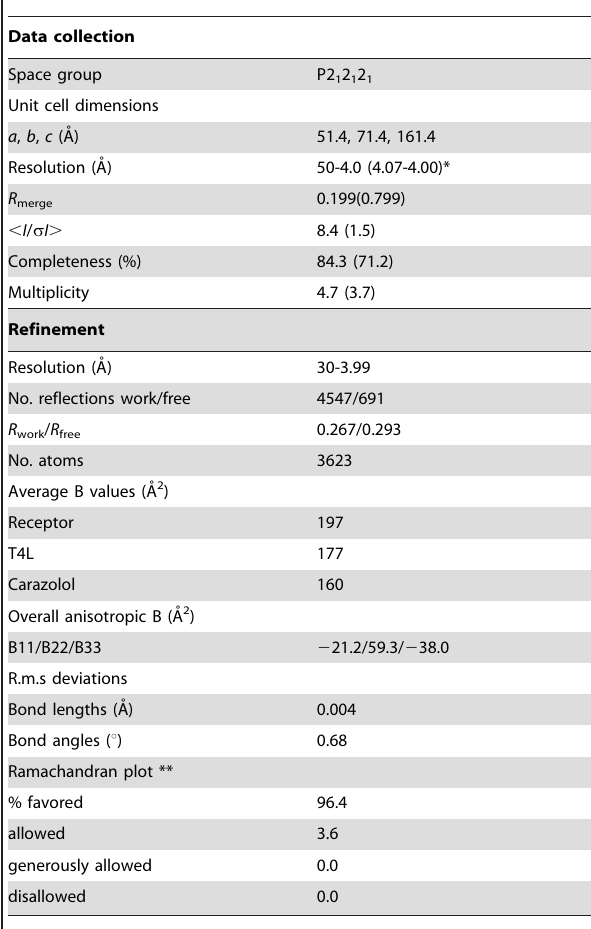
Table 1. Data collection and refinement